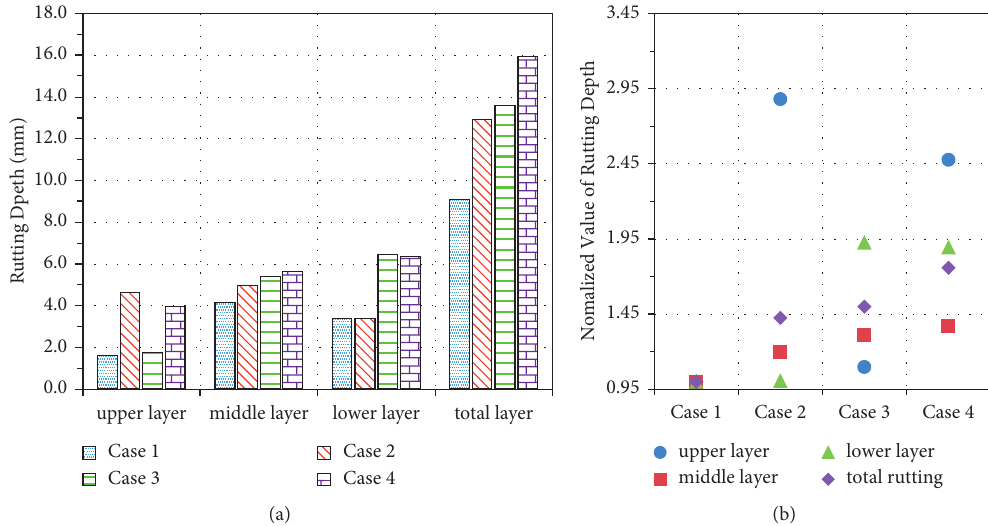
Figure 18: Effect of horizontal force and interlayer bonding on rutting depth: (a) normal value and (b) standardized